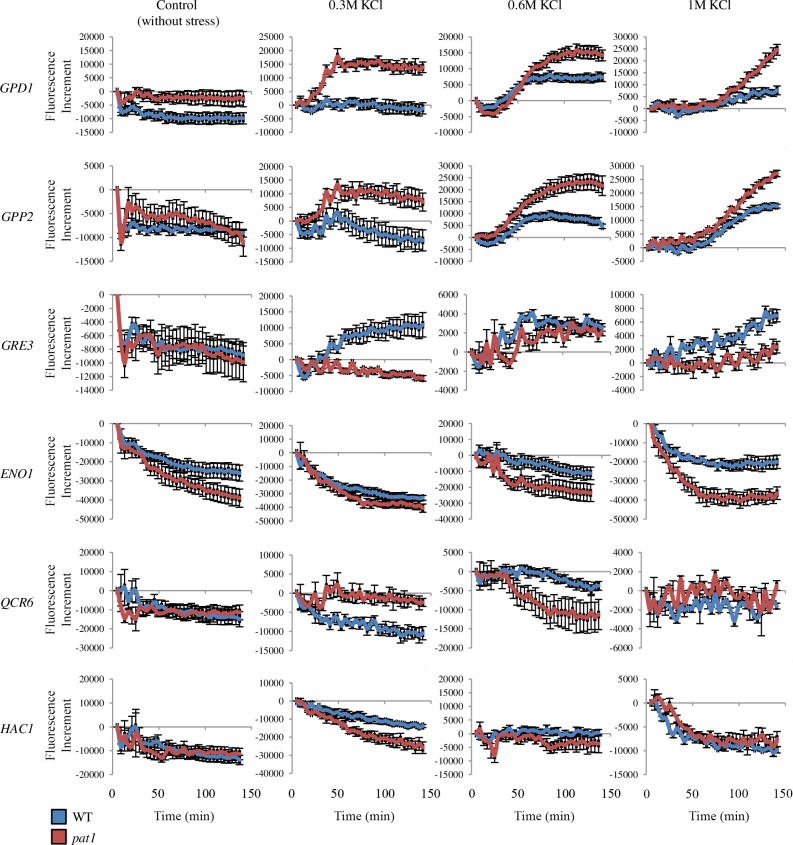
Deletion of PAT1 dysregulates synthesis of highly induced proteins under osmotic stress.The accumulation of specific GFP-tagged proteins was monitored in pat1 (red line) mutants and wt (blue line) in control conditions (without stress) and under osmotic stress by addition of KCl (mild, 0.3 M; medium, 0.6 M; high, 1 M). Protein accumulation was expressed as the increment of fluorescence units relative to 5 min after addition of KCl. Green fluorescence emission (520 nm) and OD600 was measured from the same well every 4 min for a period of 140 min in an Omega Polarstar fluorescence plate reader. To normalize the data, the OD600 was used to remove the effect of growth differences between strains, and pat1 and wt with no GFP-tagged protein growing in parallel were used to subtract the background fluorescence. Average and SE from at least three biological replicates are shown.